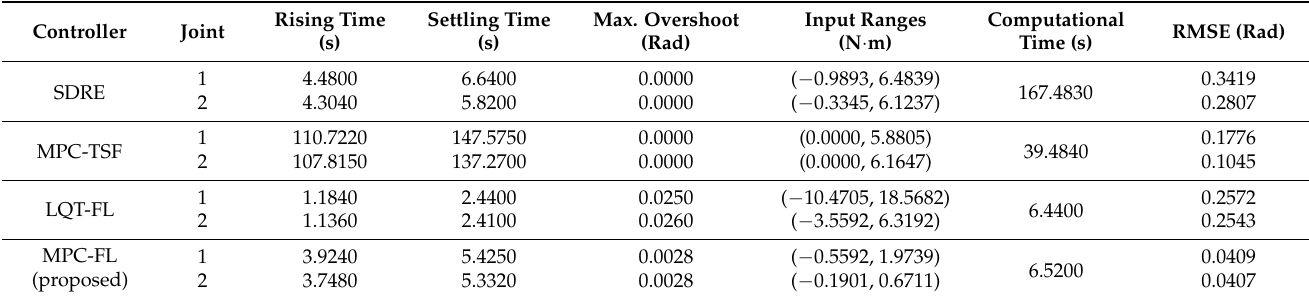
Table 6. Comparisons of control performances by applying the four control schemes without input constraints to the two-link robot